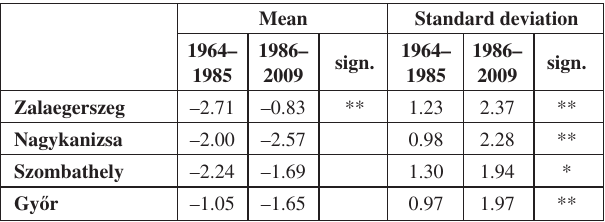
Table 1. Absolute minimum temperatures in April – summary of statistics Mean Standard